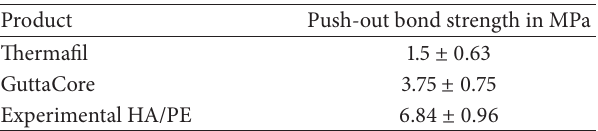
Table 2: Push-out bond strength of Thermafil, GuttaCore, and experimental carrier with gutta-percha coating. The data shows a statistically significant difference ( P < 0.001) for the three different